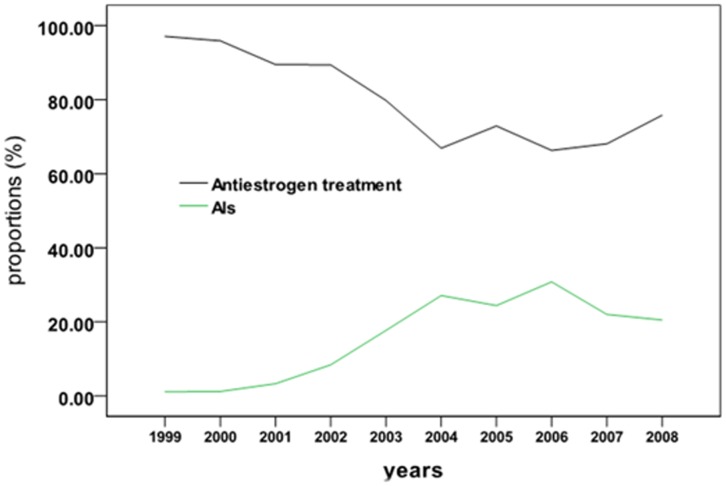
Ratios of the use of ET Drugs during 1990 and 2008.